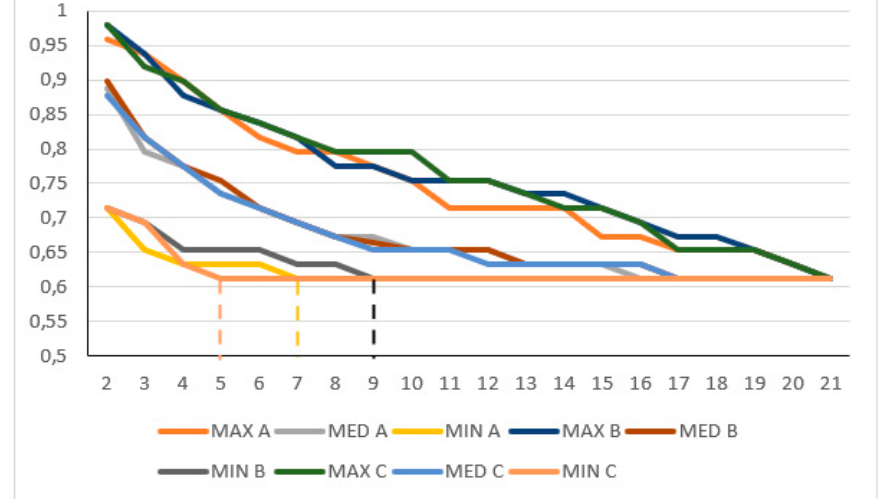
Figure 2. Partly overlapping simplified ONEST plots of 3 randomly selected 100 permutations (A, B, and C) for the <50% sTIL or more classification in C1 circulation without the two divergent classifiers; this example showed the lowest p -value in the Kruskal–Wallis test. Note: the y -axis only represents values between 0.5 and 1; despite not being statistically significantly different, the 3 randomly selected ONEST plots of 100 permutations yield 3 different ONEST values: 7 (A), 9 (B), and 5 (C) (to ease reading of the values, these are highlighted by vertical dashed segments between the x -axis value and the minimum curves), whereas the bandwidth is very similar (0.245 A, 0.265 B and C), and by definition, the OPA(21) value is identical (0.612). MAX: maximum curve; MED: median curve; MIN: minimum curve.